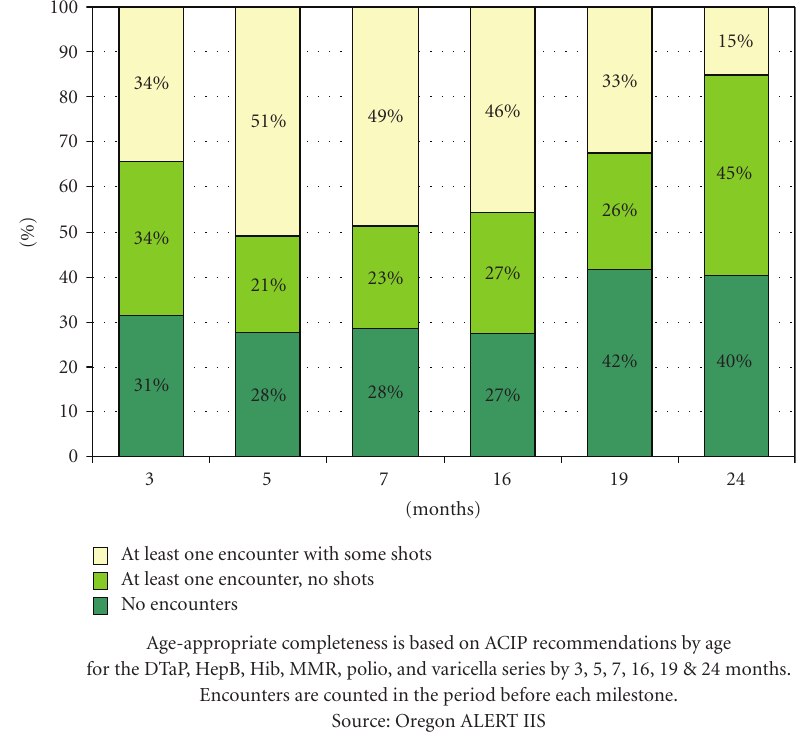
Figure 3: Provider Encounters by Milestones for Children Lacking Complete Age-Appropriate